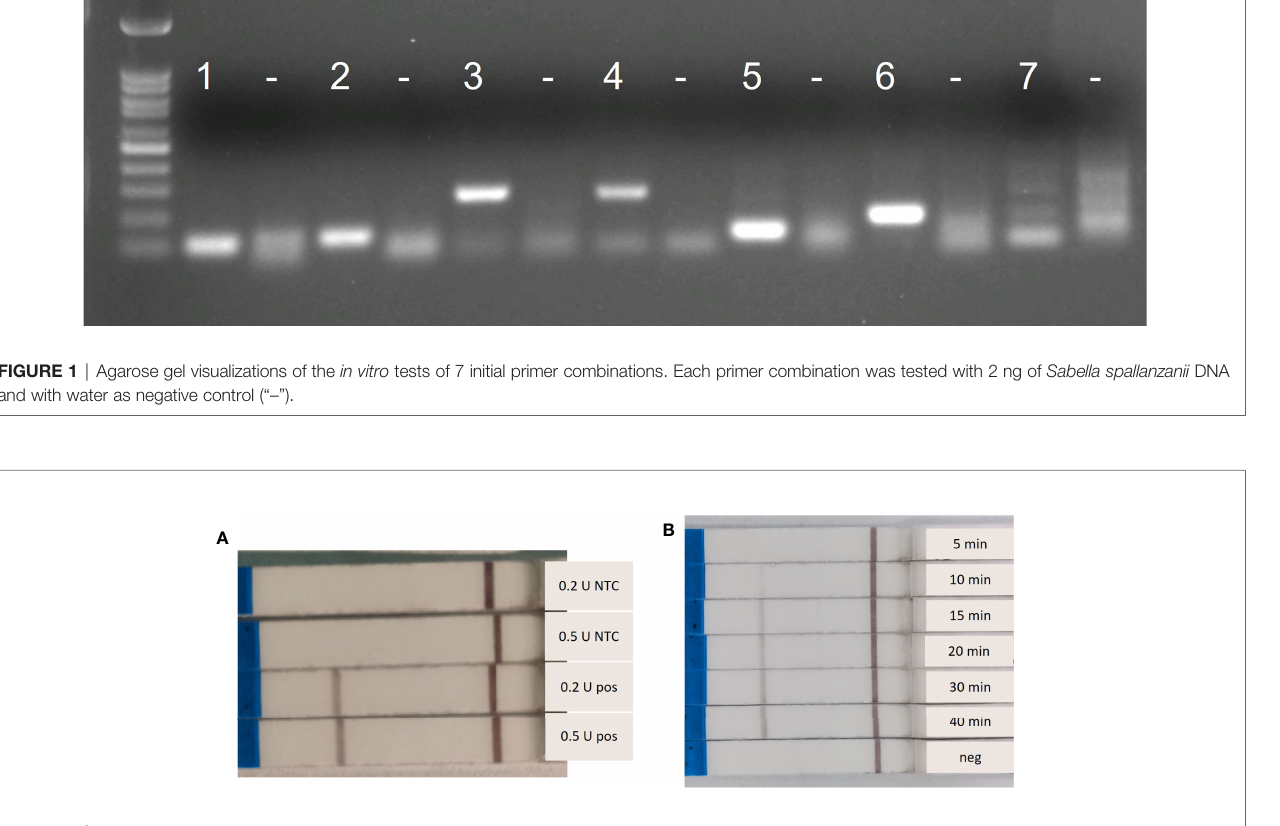
FIGURE 2 | Dependence of the Recombinase Polymorphism Ampli fi cation-Lateral Flow (RPA-LF) ampli fi cation strength on Endonuclease IV concentration and incubation time. (A) Endonuclease IV was tested at 0.2 U and 0.5 U per reaction with (pos) and without (NTC) Sabella spallanzanii DNA. (B) ampli fi cation of 5 – 40 minutes were tested, including a negative sample